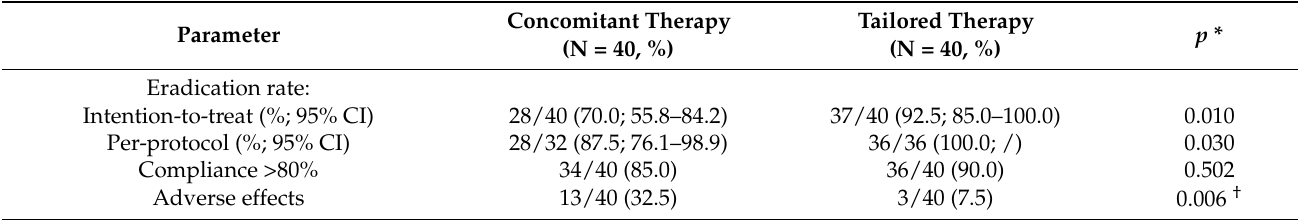
Table 2. The clinical outcomes of the study population.